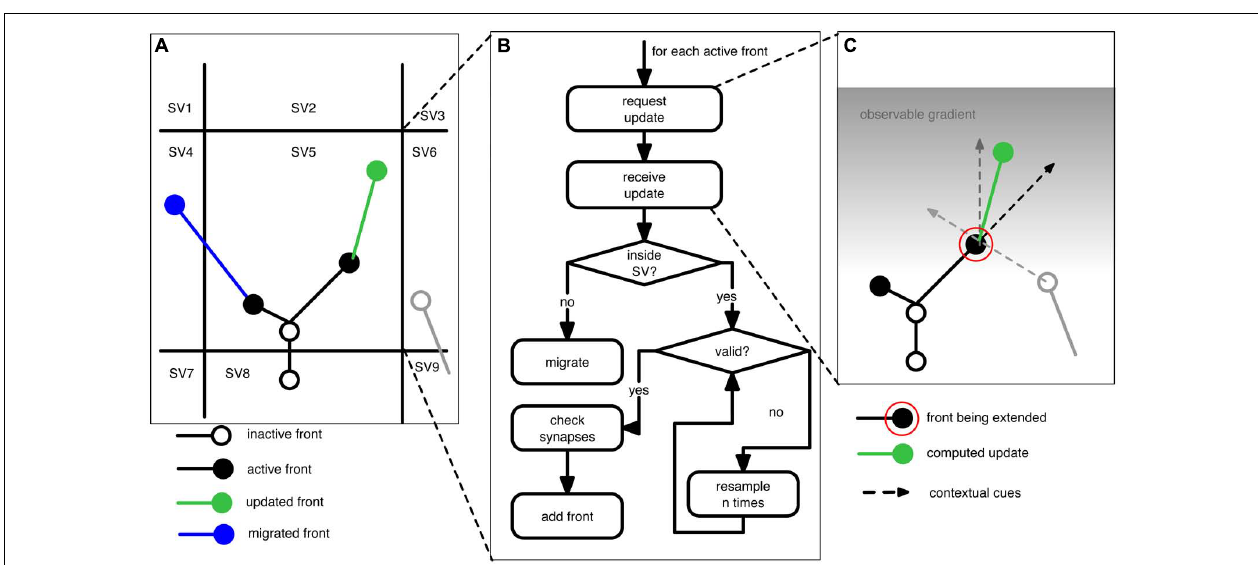
FIGURE 1 | Schematic of the proposed context-aware framework, NeuroMaC, to generate virtual morphologies. (A) The simulated brain substrate is decomposed into small sub volumes (SVs). Sub volumes keep track of all neurites and other relevant actors inside their spanning volume. (B) Algorithm performed by each sub volume during one simulated, centrally controlled time step. (C) Fronts are implemented as cellular automaton-like machines and conceptually related to growth cones in that